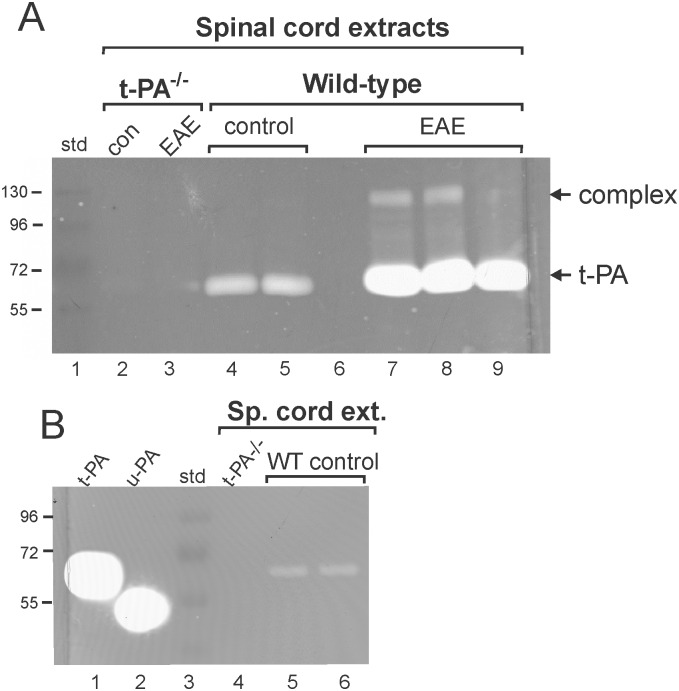
Fibrin zymographic analysis of t-PA activity in spinal cord extracts of mice subjected to EAE.(A): Spinal cord extracts (50 μg protein loaded per lane) from MOG35-55 immunized t-PA-/- and wild-type mice at NSS stage 3 of EAE were subjected to SDS-PAGE electrophoresis and fibrin zymography. As shown, wild-type mice demonstrated an increase in t-PA activity following EAE. Also evident is the presence of a slower migrating fibrinolytic moiety present following EAE most likely representing t-PA:PAI-1 complex formation. (B): Fibrin zymogram performed using t-PA and u-PA standards showing that the plasminogen activator activity seen in spinal cord extracts from wild-type (WT) control mice co-migrates with t-PA (note that the samples run in lanes 5 and 6 in (B) were the same samples loaded to lanes 4 and 5 in (A). Extracts from t-PA-/- mice were also used as a control to indicate the absence of both t-PA and u-PA.